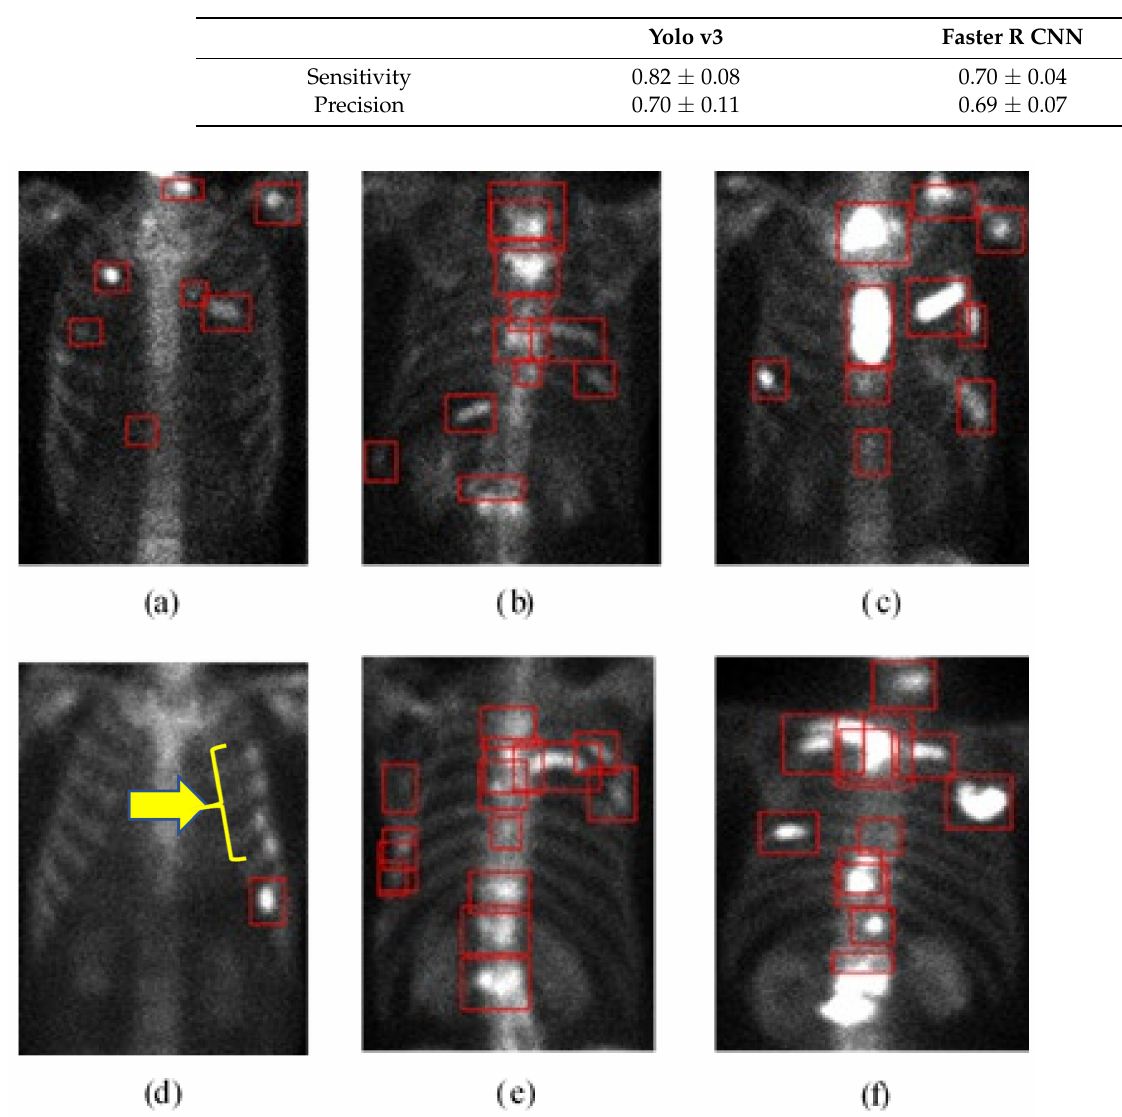
Figure 6. Detection and classification results of the chest NN. All the red marks denote predicted metastasis lesions by the chest NN (Yolo v3). ( a ) Case no. 13, TPR = 6/7. ( b ) Case no. 108, TPR = 8/12. ( c ) Case no. 127, TPR = 10/10. ( d ) Case no. 137, FP = 1. ( e ) Case no. 152, TPR = 8/10. ( f ) Case no. 165, TPR = 8/9. TPR is true positive rate, FP is false